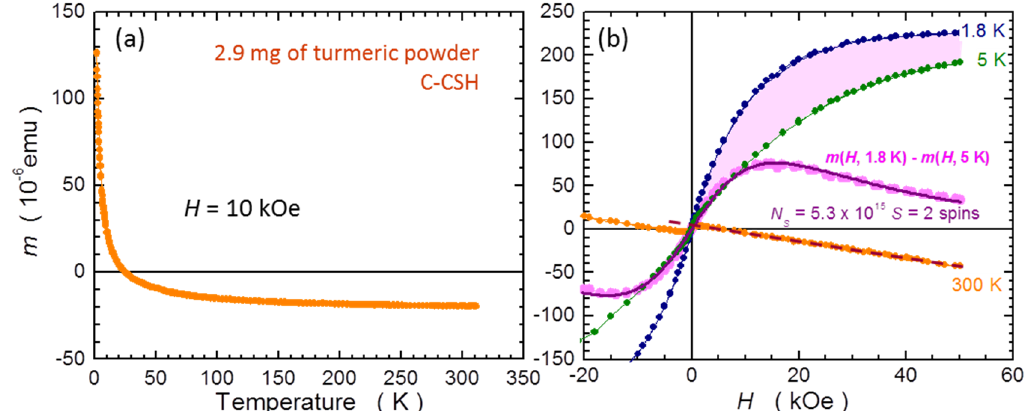
Figure 15. Results of the magnetic studies of 2.9 mg of common turmeric powder performed in capsule compensated sample holder (C-CSH). ( a ) Temperature dependence of magnetic moment m measured at external magnetic field H = 10 kOe. ( b ) Values of m ( H ) at 300, 5, and 1.8 K. The brown dashed line yields the magnitude of diamagnetic susceptibility of the sample χ turmeric ≅ − 3.3 × 10 − 7 emu/g/Oe. The magenta area and bullets mark the difference between m ( H ) at 2 and 5 K. The solid purple line indicates difference between Brillouin functions calculated for S = 2 (Equation (A2) in Appendix D). The matching factor between the theory and experiment, N S = 5.3(1) × 10 15 , yields the number of paramagnetic S = 2 spins in the sample.